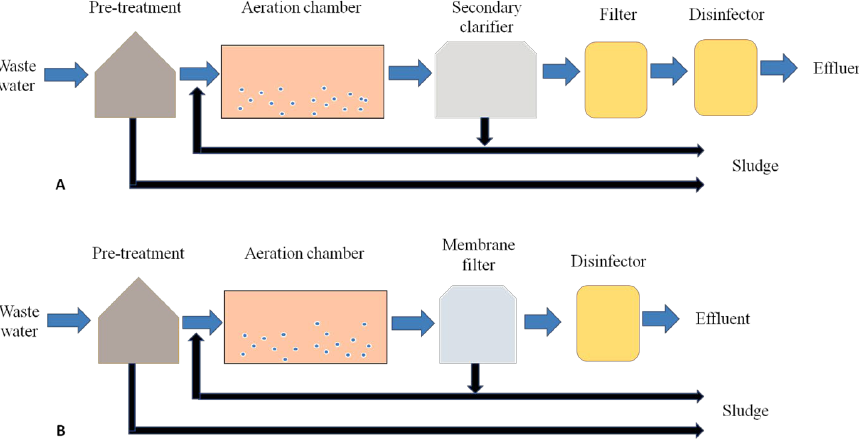
Figure 4. Flowchart of ( A ) the activated sludge process and ( B ) membrane bioreactor (MBR) tech- nology.